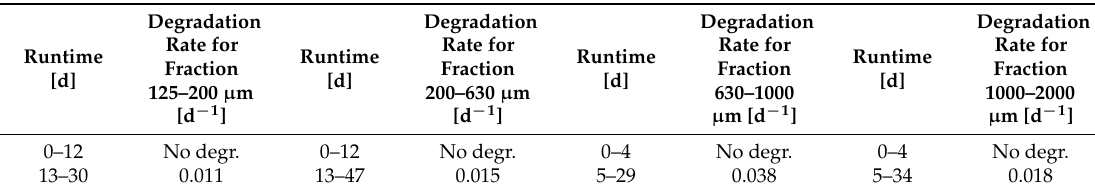
Table 5. Calculated degradation rates for each